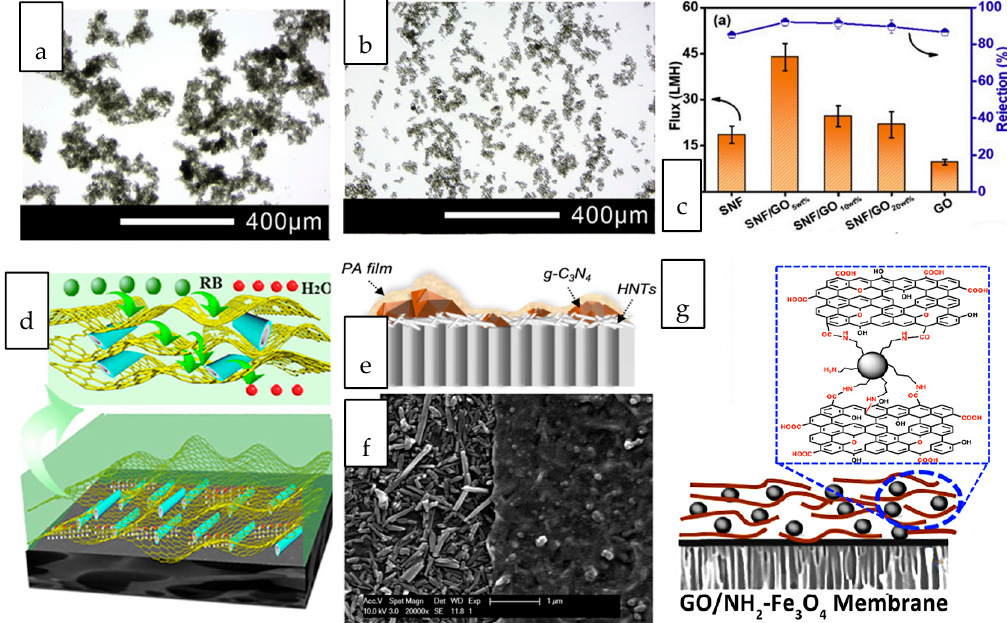
Figure 5. Optical images of ( a ) carbon nanotube (CNT) and ( b ) CNT/GO dual nanofiller dispersed in aqueous-based solution. ( c ) nanocomposite membranes incorporated with SNF/GO x exhibited drastically improved Na 2 SO 4 rejection and flux for the SNF, GO, and membranes [156] ( d ) conceptual illustration of water transport path and nanocapillary network jointly created by porous reduced graphene oxide/halloysite nanotubes (PRGO/HNTs) (RB: Reactive Black) [157] ( e ) Schematic illustration of cross section and ( f ) surface image of TFN membrane incorporated with g-C 3 N 4 / HNT. The left part with the PA scraped off revealed the orientation of HNT [158], ( g ) Schematic illustration of NH 2 -Fe 2 O 3 intercalated GO nanosheets [159].